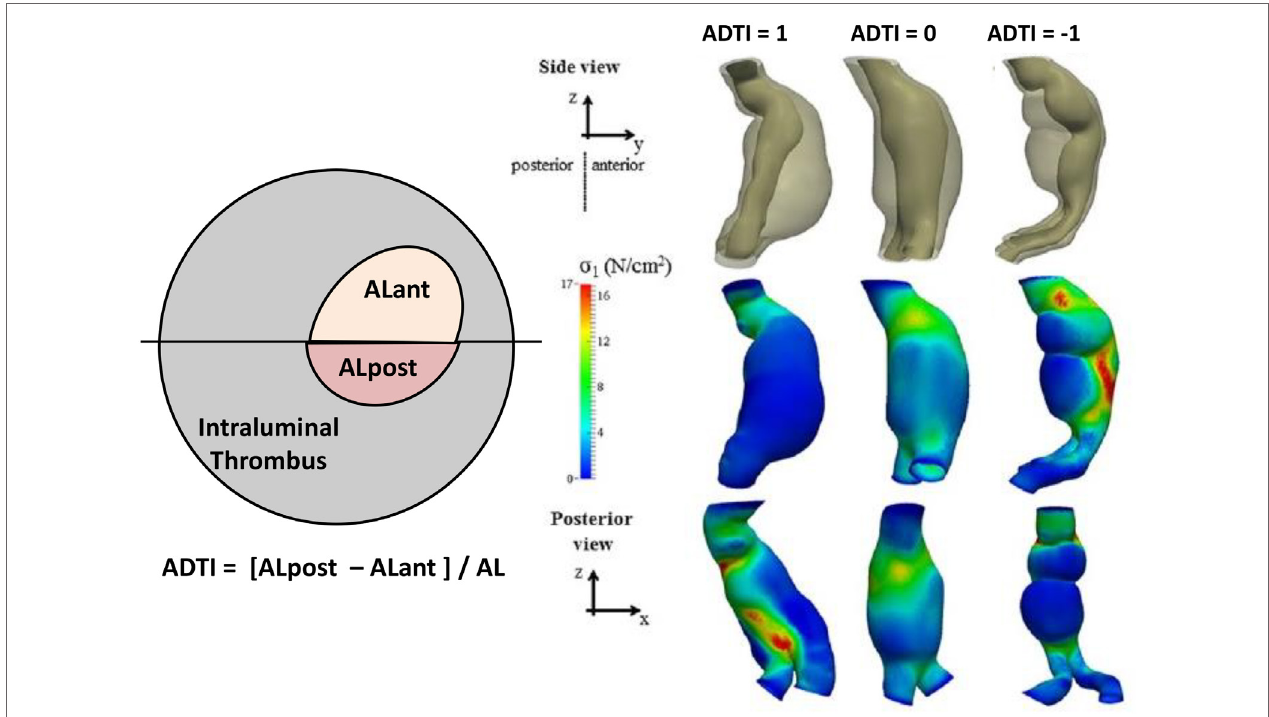
FiGURe 1 | Definition of asymmetrical thrombus deposition index (ATDi). In this example, ATDI is negative. The black line determines the anterior and posterior sides, and the luminal areas at the anterior (ALant) and the posterior (ALpost) sides are measured. Also depicted are three examples of different ADTI ranging from + 1 to − 1 along with their wall stress distribution. Figure modified from Ref.